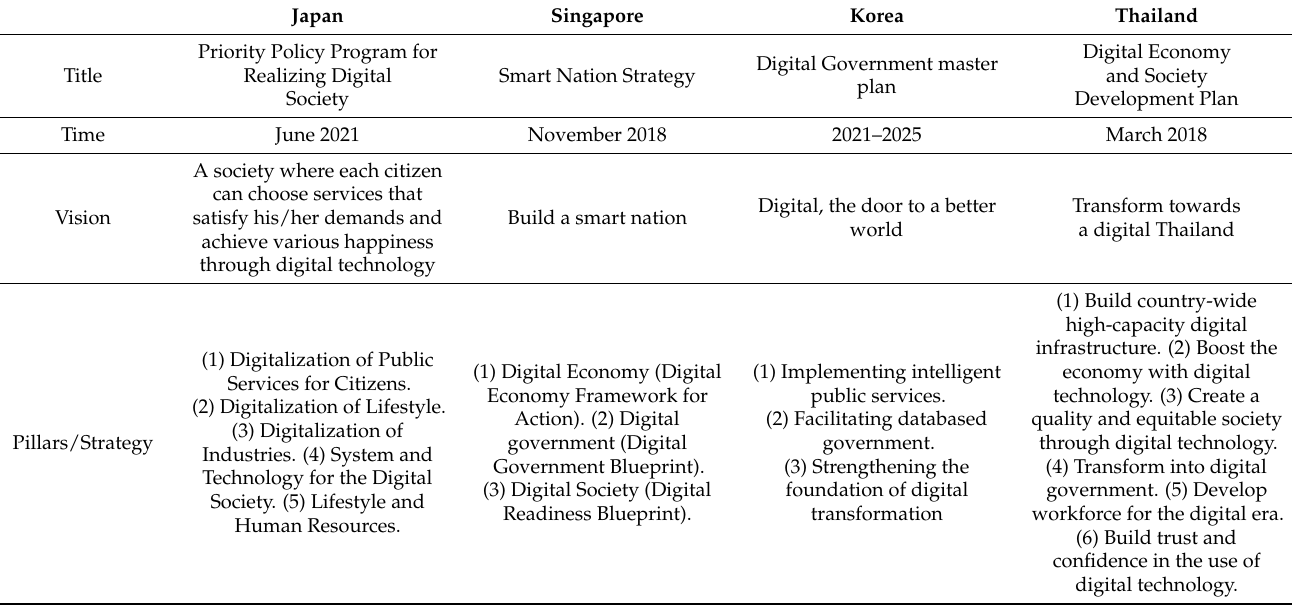
Table 2. Current national ICT policy of Japan, Korea, Singapore, and